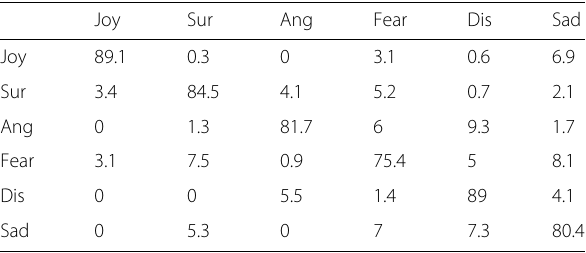
Table 11 Confusion matrix (%) of cross-validation